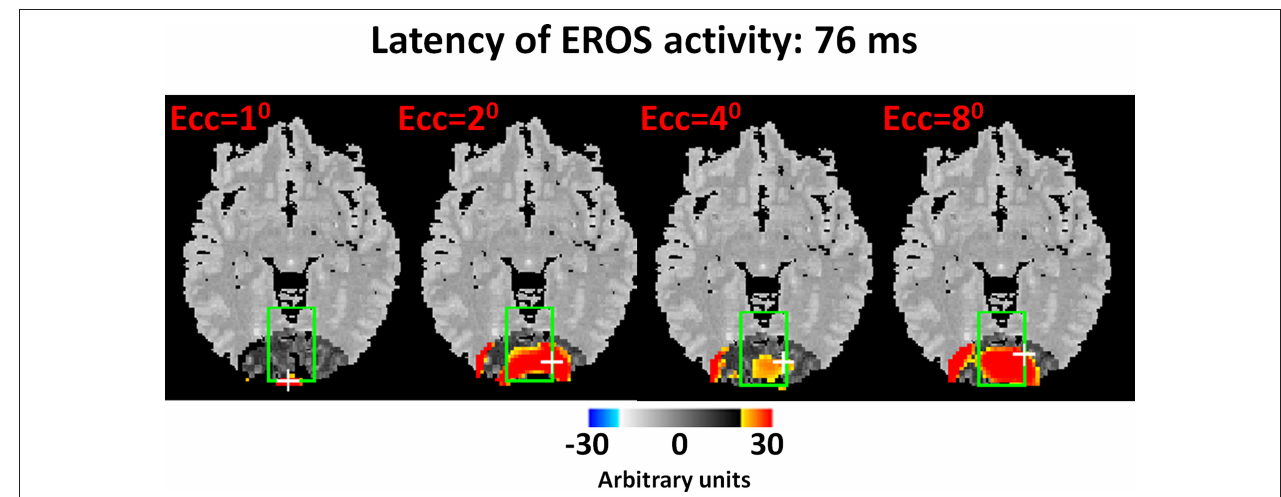
in MNI space) obtained at a latency of 76 ms from stimulation (sampling rate was 25.6 ms). The white crosses indicate the peak points. The data are displayed in arbitrary phase